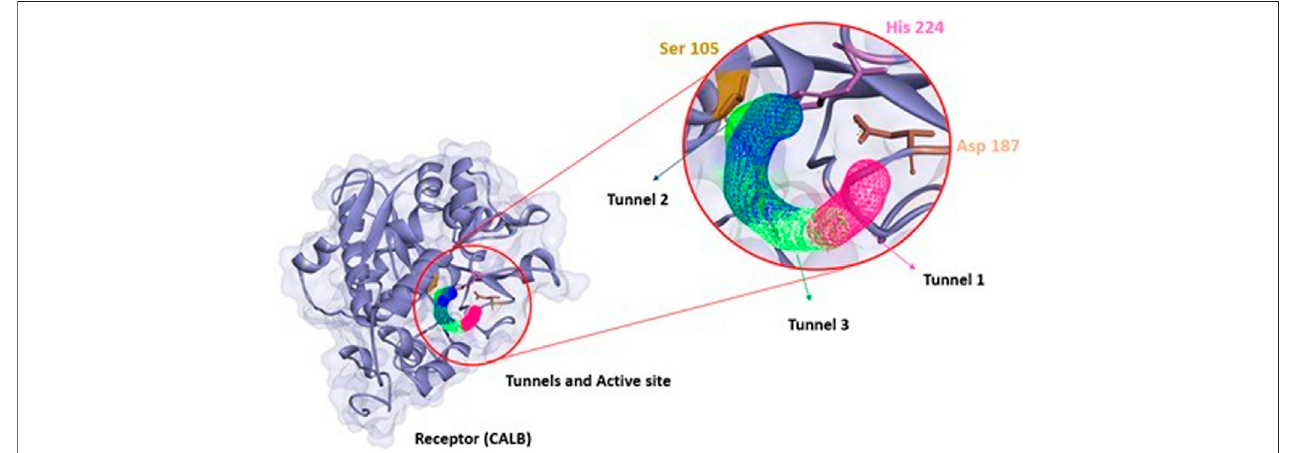
FIGURE4 | Structure ofCALB (PDB:5A6V) with tunnels (tunnel1 pink, tunnel 2green, and tunnel 3blue), and the respective active site (Ser 105, Asp 187 and His 224) calculated using CaverWeb and identi fi cated using Discovery